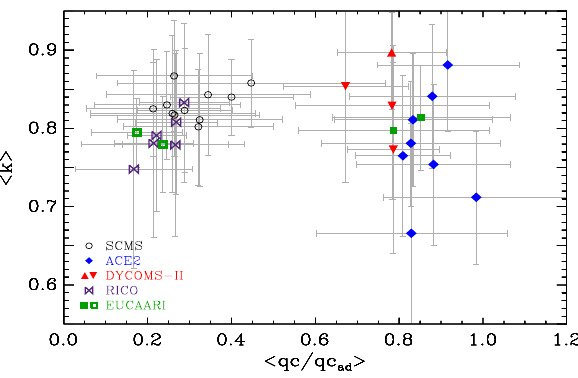
Fig. 4. Scatterplot of h k i values as function of the LWC adiabatic fraction. For the LWC adiabatic fraction, the difference between the 80th and the 20th percentile of the frequency distribution is used as the error bar instead of the standard deviation to represent the variability. Symbols depend on the project as indicated in the legend with open and solid symbols for Cu and Sc clouds, respectively. For DYCOMS-II pointing up triangle is for Fast-FSSP data and pointing down triangles are for SPP-100